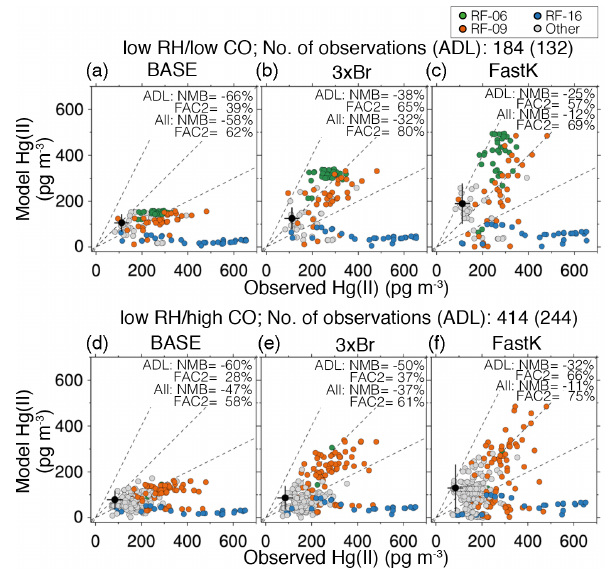
Figure 5. Scatterplot of observed and simulated concentrations of Hg(II) for the three model simulations in the (a–c) “low RH/low CO”, and (d–f) “low RH/high CO” categories. Each column corre- sponds to our three GEOS-Chem simulations: BASE (left column), 3 × Br (middle column) and FastK (right column). Observations for RF-06 (green), RF-09 (orange), and RF-16 (blue) are highlighted in color, with the remaining observations indicated by gray symbols. The black circles and error bars represent the mean and standard de- viations of values below the detection limit (BDL) estimated with the ROS method for each air mass category separately and the cor- responding simulated concentrations. The Normalized Mean Bias (NMB) and fraction of points where the model is within a factor of 2 of the observations (FAC2) are indicated on each panel (see text for